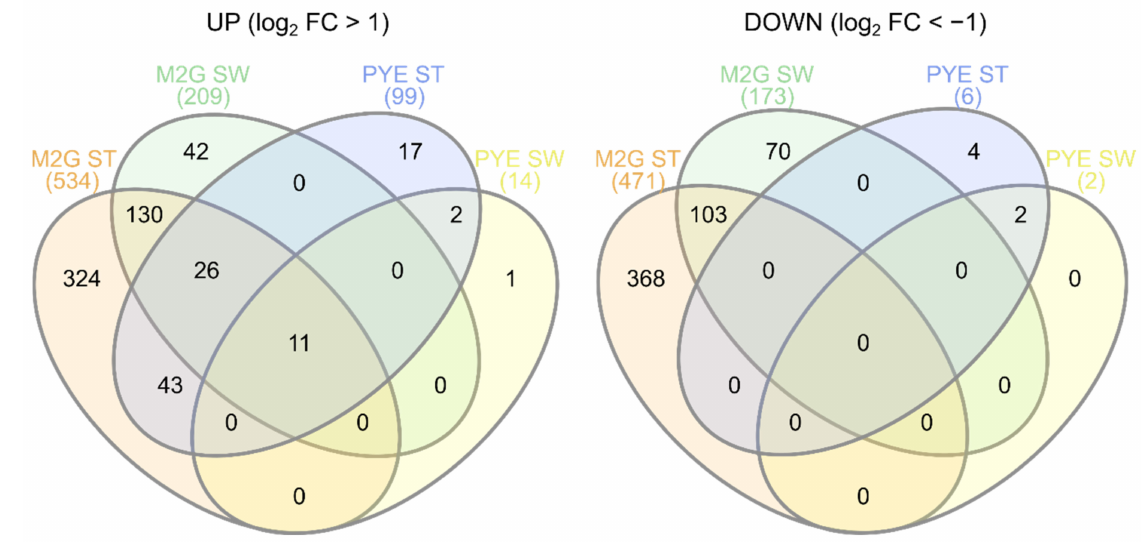
Figure 5. Venn diagrams showing overlap between upregulated ( left ) and downregulated ( right ) genes upon Cu stress in all experimental conditions.